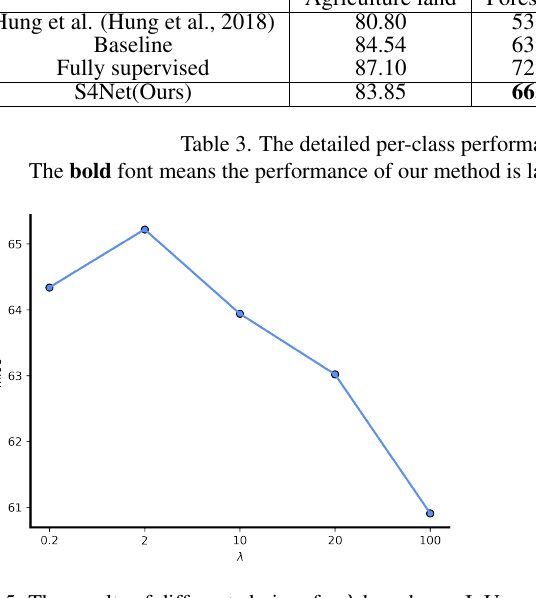
Figure 5. The results of different choices for λ based on mIoU on validation dataset.